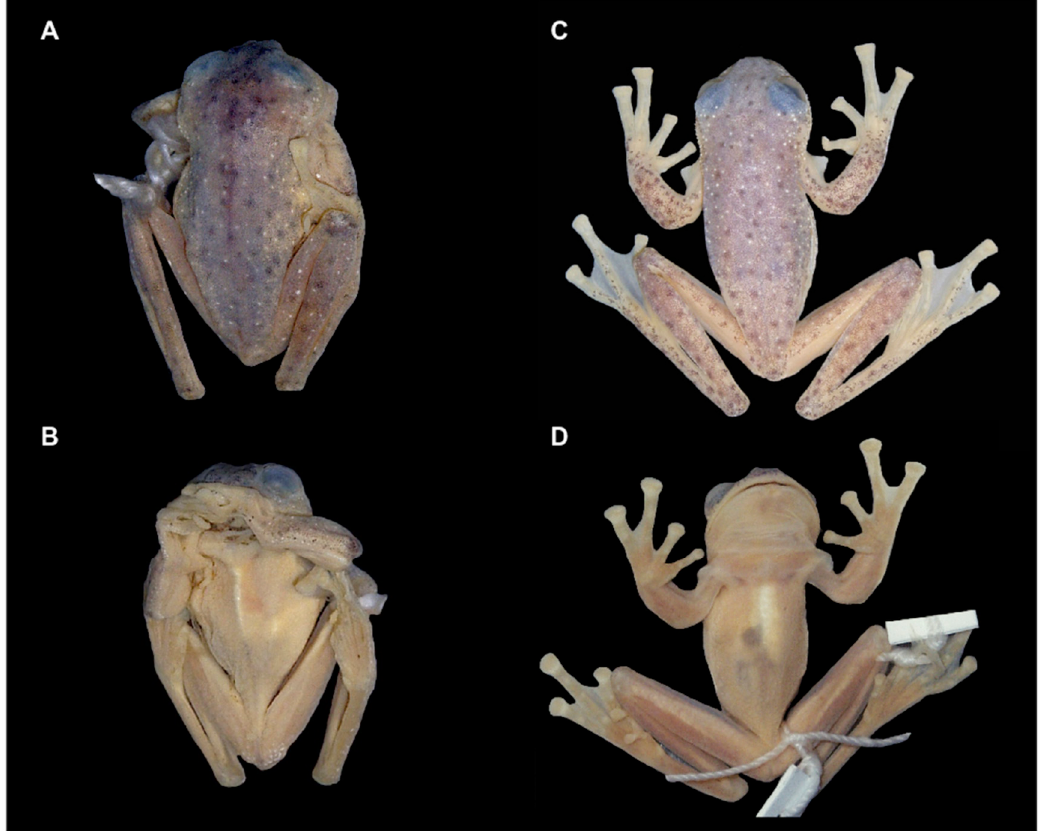
Figure 44. Type material of Centrolene lynchi and C . gemmata in preservative. ( A , B ) C . gemmata , MCZ 104077, paratype. ( C ) C . lynchi , KU 164698, paratype, dorsal view. ( C ) C . lynchi , KU 164691, holotype, 104077, paratype. ( C ) C . lynchi , KU 164698, paratype, dorsal view. ( D ) C . lynchi , KU 164691, holotype, ventral view. ventral